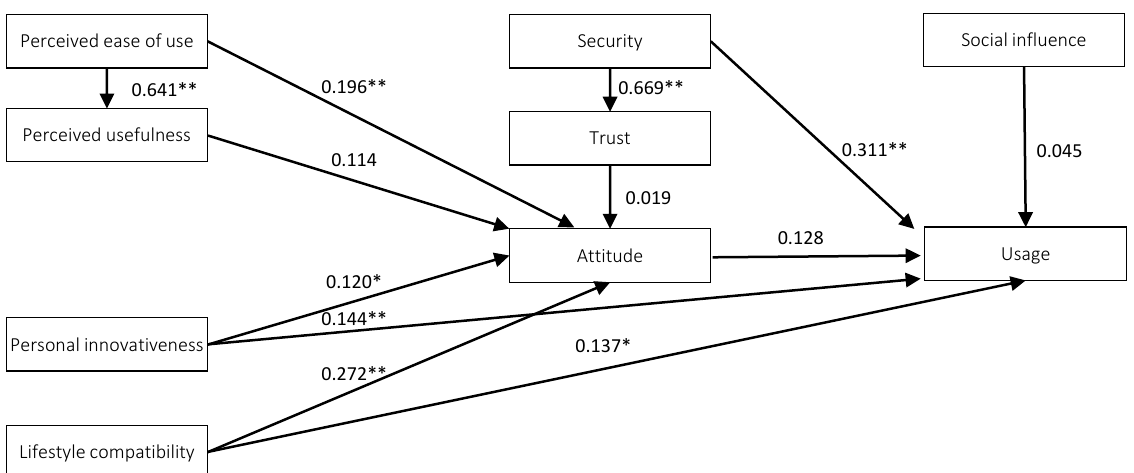
Figure 2. Structural